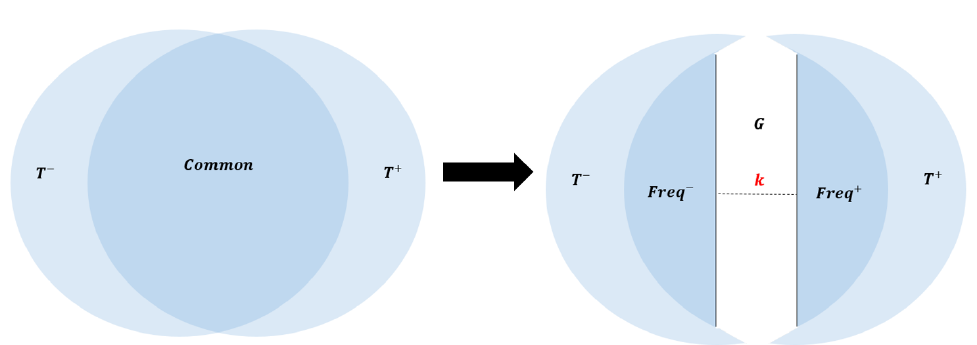
Figure 1. Common term